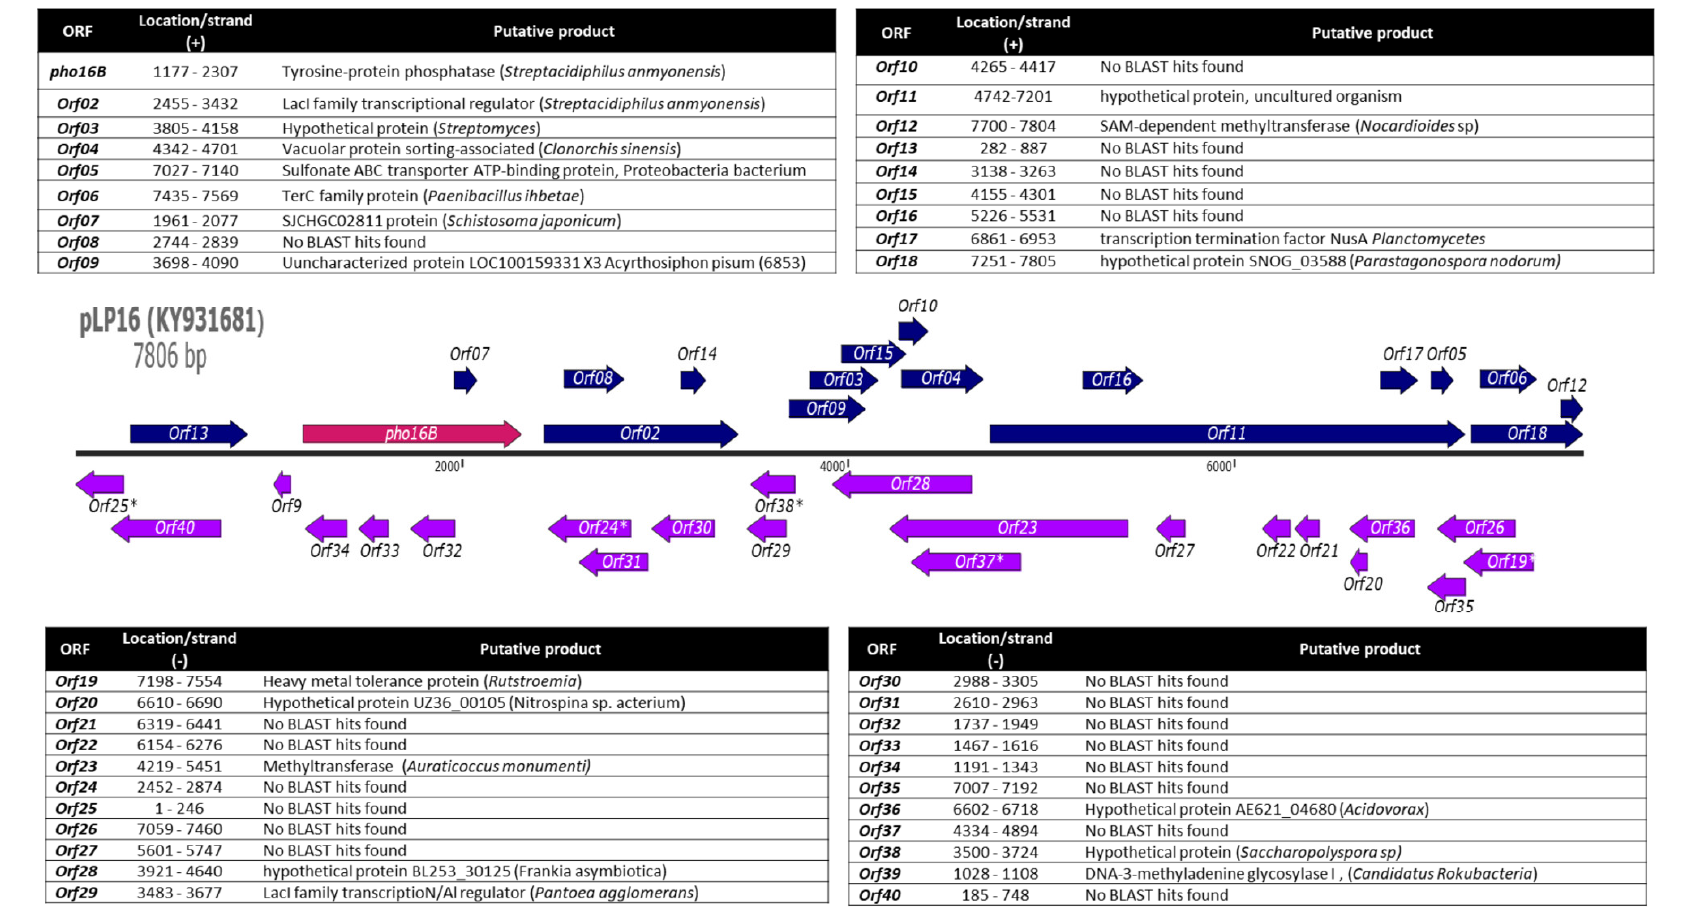
Figure 1. Strand, location, and BLAST results for all identified open reading frames (ORFs) of the pLP16 insert. * Partial ORFs.